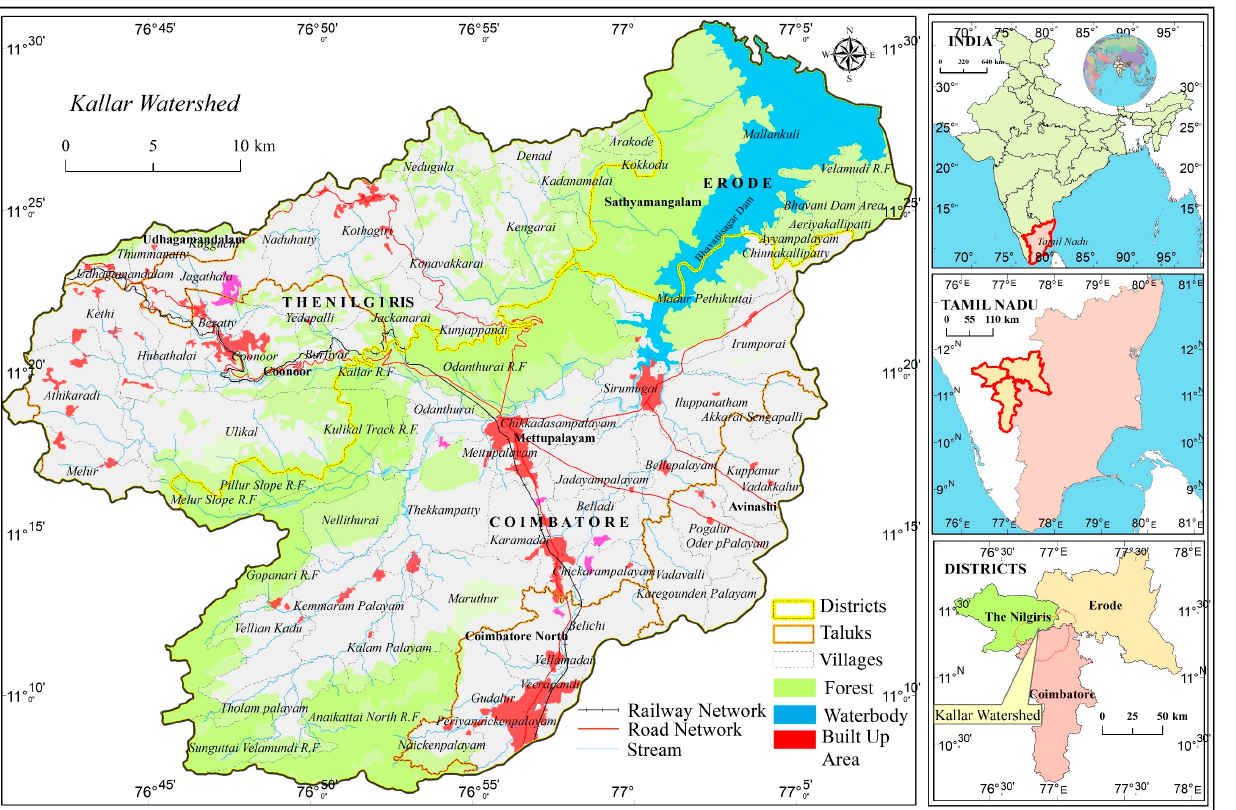
Figure 1. Location—physical and cultural setting of the study area.